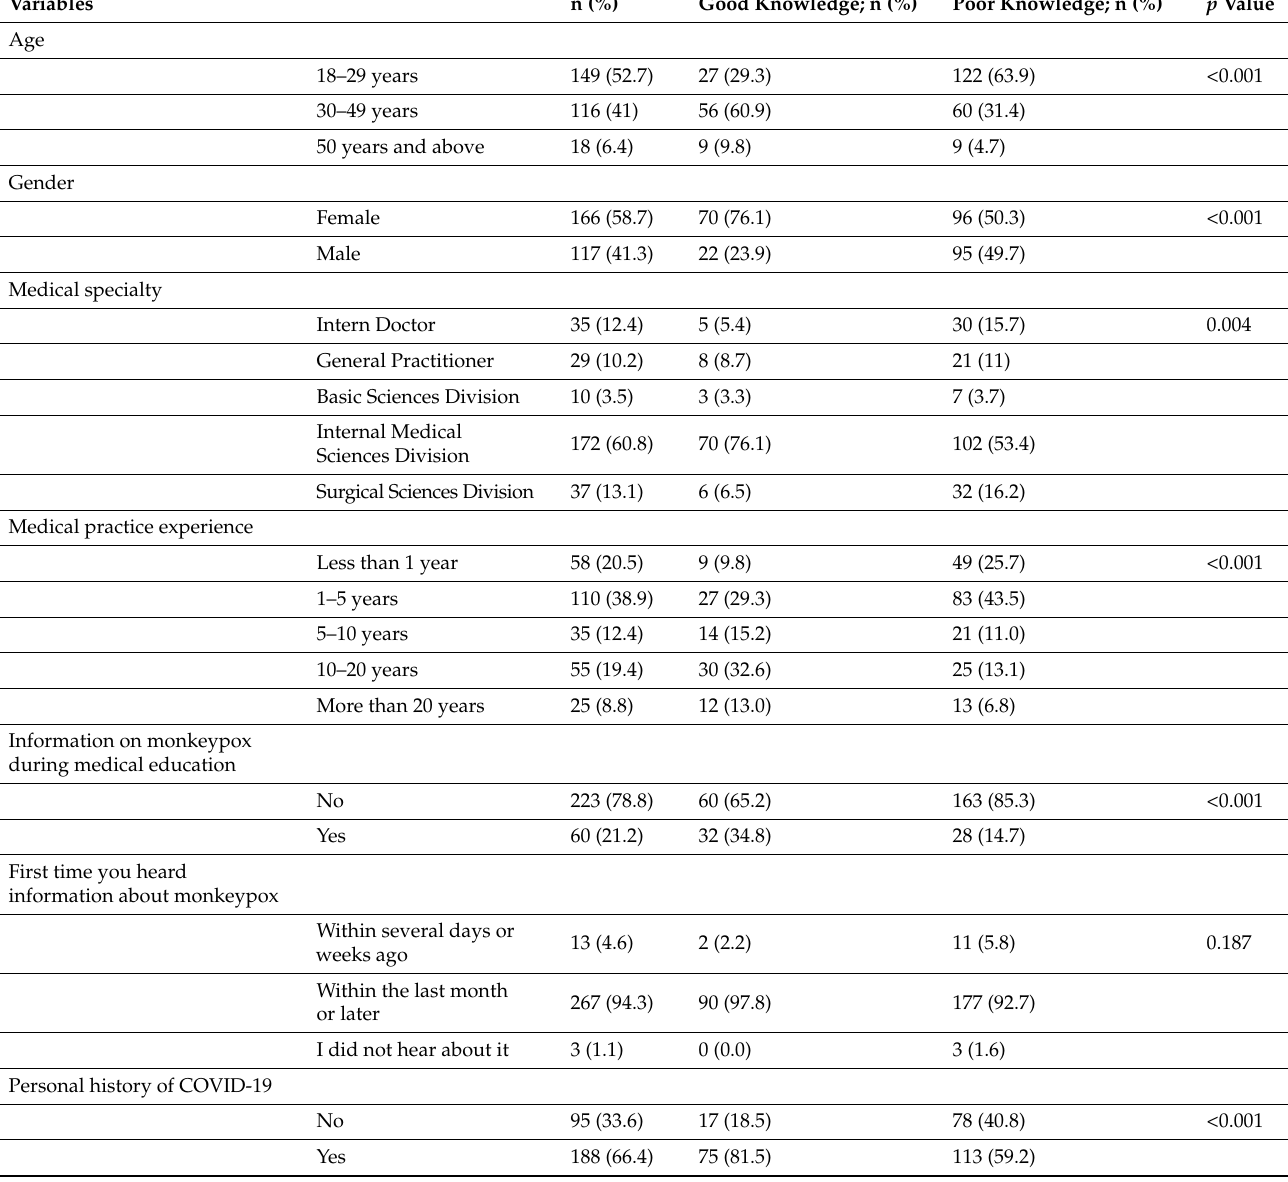
Table 2. Association between baseline characteristics and knowledge score about monkeypox disease among physicians (n =